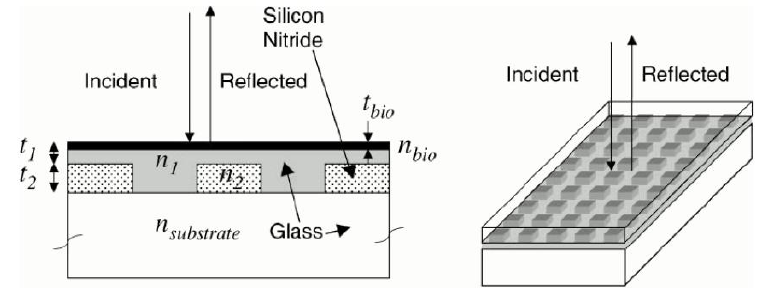
Figure 7. Schematic diagram of the photonic crystal used for colorimetric resonant reflection. Reproduced from [72] with permission from